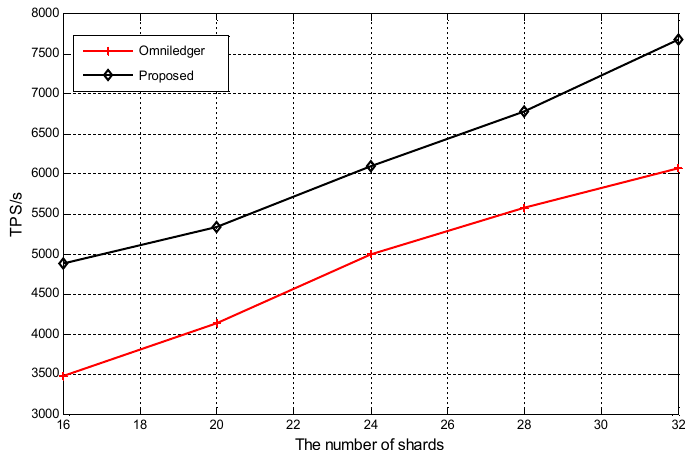
Figure 10. The experimental results of TPS.